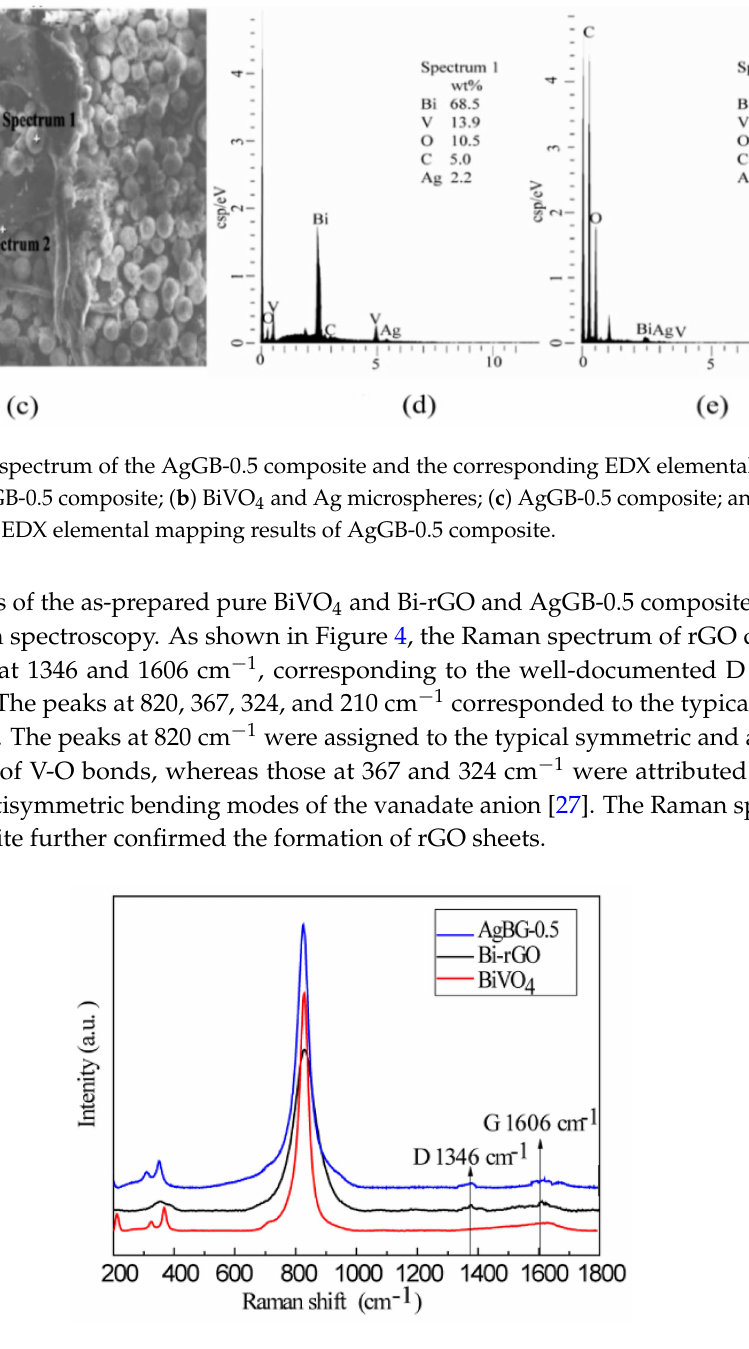
Figure 4. Raman spectra of the pure BiVO 4 and Bi-rGO and AgGB-0.5